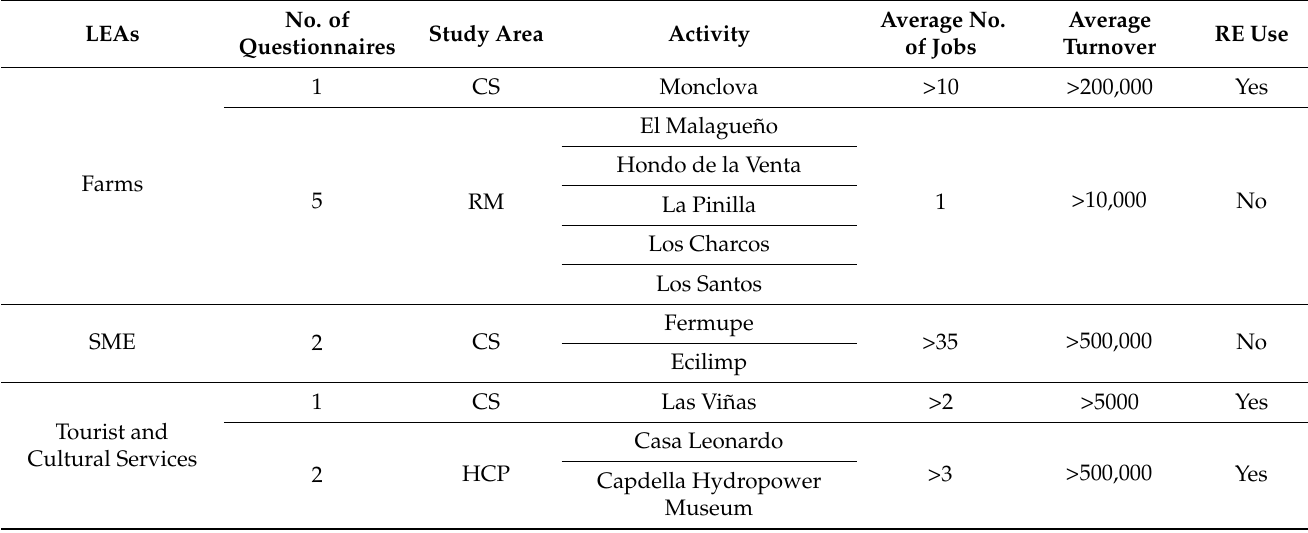
Table 2. Local economic activities